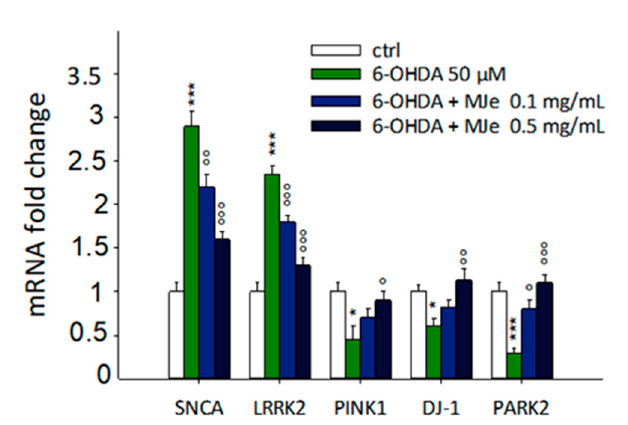
Figure 9. Modulatory effects of MJe on mRNA levels of Parkinson-related genes modulated by 6-OHDA. SH-SY5Y cells were pretreated with MJe for 1 h and then exposed to 6-OHDA 50 µ M for additional 24 h. Messenger RNA levels were quantified with real-time PCR, and their relative quantities were calculated through the 2 – ΔΔ CT method. Results are expressed as fold change relative to untreated cells. Data are expressed as mean ± SEM of three separate experiments in triplicate (N = 9). * p < 0.05, *** p < 0.001 vs. control; ° p < 0.05, °° p < 0.01 and °°° p < 0.001 vs. 6-OHDA 50 μ M.